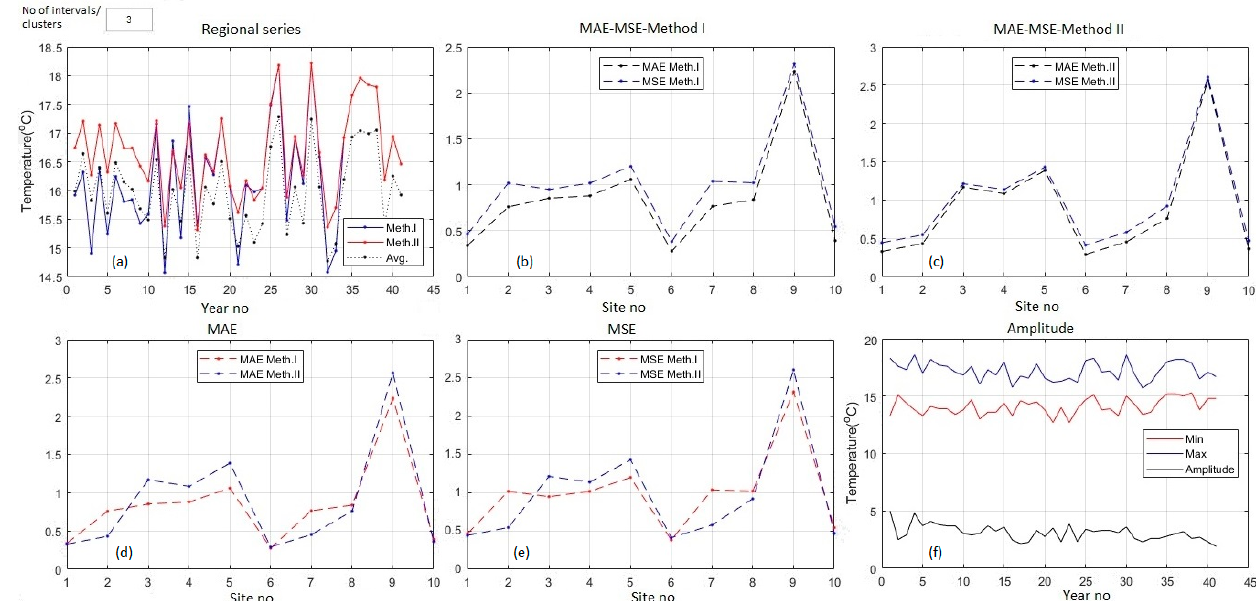
Figure 11. The case of three intervals/clusters for the series of maximum temperatures: ( a ) the regional series; ( b ) MAE and MSE—Method I; ( c ) MAE and MSE—Method II; ( d ) comparisons of MAEs; ( e ) comparisons of MSEs; ( f ) min, max, and amplitude of the average temperatures series . When n = 3 (Figure 11), the ‘Regional series’ issued from the second algorithm ob- tained the highest values, and the average MAE (MSE) from Method I was smaller (higher) than from Method II. The algorithm produced the highest MAEs and MSEs for station 9—Sulina (Figures 10c–e and 11c–e) in all cases.